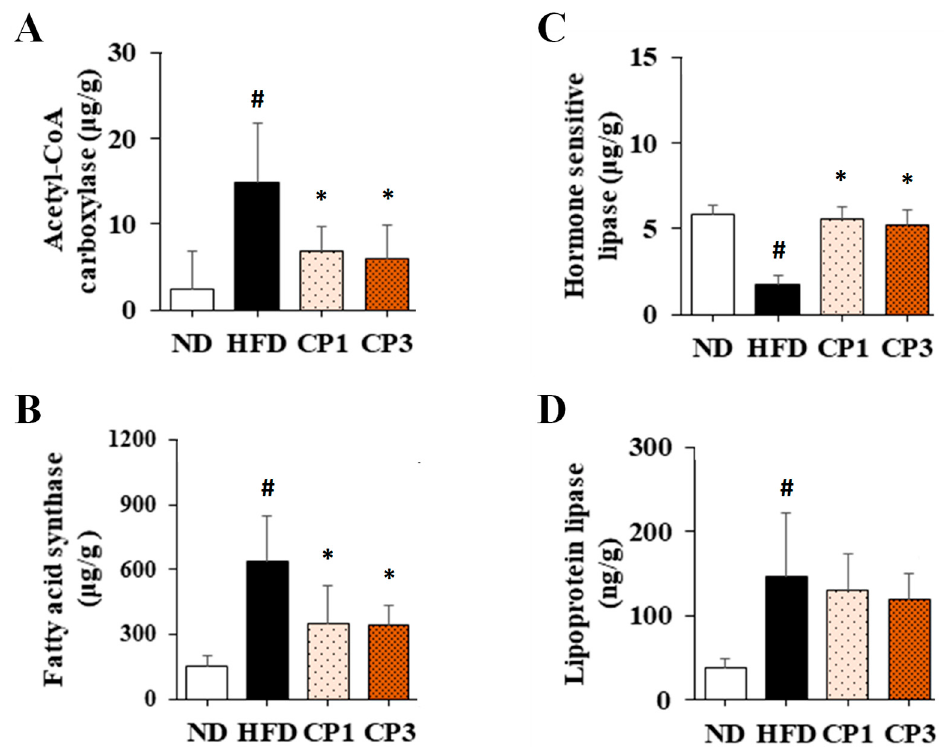
Figure 6. The levels of ( A ) acetyl-CoA carboxylase and ( B ) fatty acid synthase in liver and ( C ) hormone sensitivity lipase and ( D ) lipoprotein lipase in visceral fat of rats. After 16-week treatment, the rats were sacrificed, and the liver and visceral fat samples were isolated to determine the levels of acetyl-CoA carboxylase, fatty acid synthase, hormone sensitivity lipase and lipoprotein lipase, respectively, as described in the Materials and Methods section. Results are expressed as mean ± S.D. for each group of rats ( n = 6). # p < 0.05 compared with the ND group; * p < 0.05 compared with the HFD group.